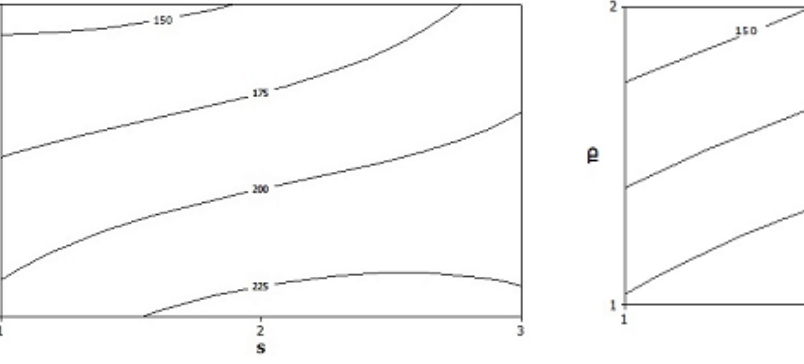
Fig. 7. Counter diagram of average water droplet size in terms of demulsifier types and water/oil volume ratio.